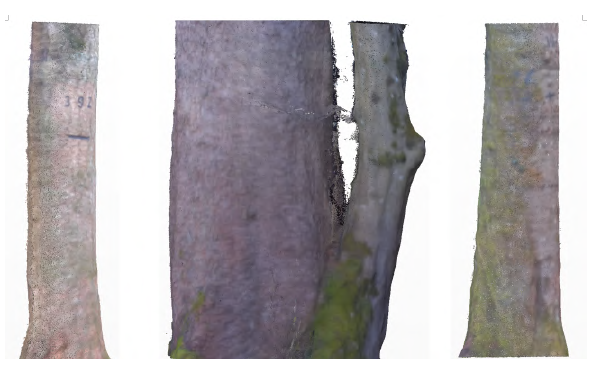
Figure 1. Photogrammetry point clouds: (left) Douglas Fir, (middle) Spruce and Hornbeam and (right) Cherry